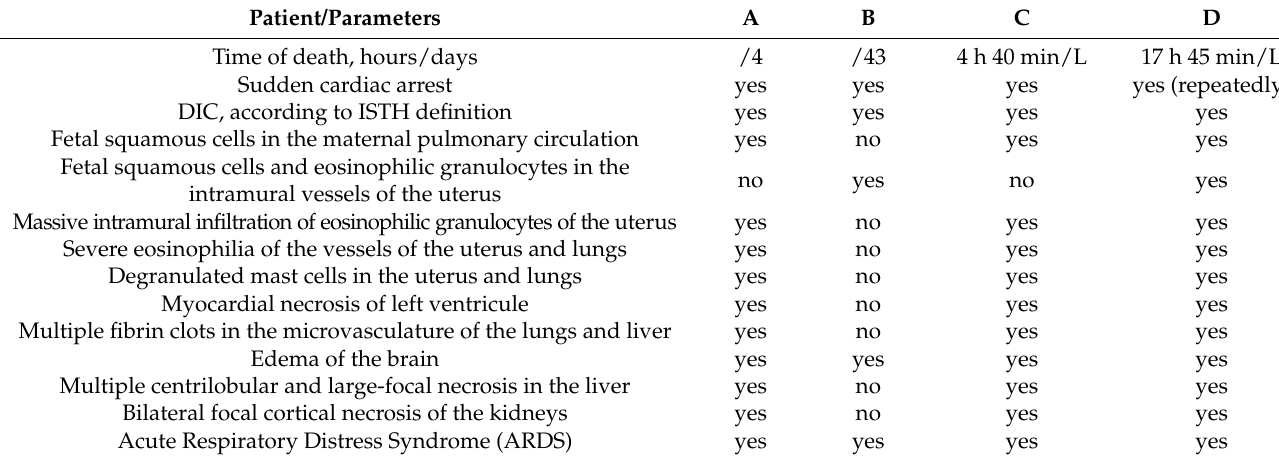
Table 2. Clinical data and patient autopsy reports.